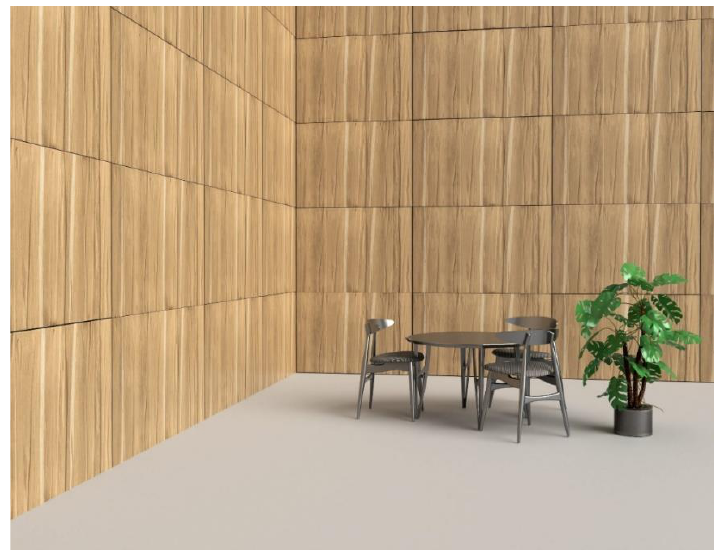
Figure 5. 3D Visualization example of decorative wooden wall panel from veneer residue created by multi- layer pressing and gluing (© Domagoj Mamić, 2022).